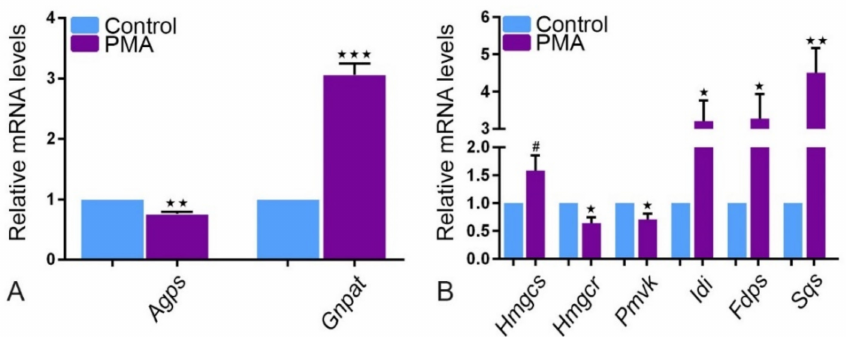
Figure 5. Peroxisomal ether lipid and cholesterol synthesis in PMA. The mRNA expression by real-time PCR analysis of ( A ) Agps (** p = 0.0018), ( B ) Hmgcr (* p = 0.0235) and Pmvk (* p = 0.0478) are expressed lower while Gnpat (*** p = 0.0004) ( A ), Hmgcs, Idi (* p = 0.0155), Fdps (* p = 0.0257) and Sqs (** p = 0.0059) ( B ) are expressed higher in PMA than in healthy tissue. (Explanation of the notations: The number of asterices signifies the degree of significance of the p -value, while # means not